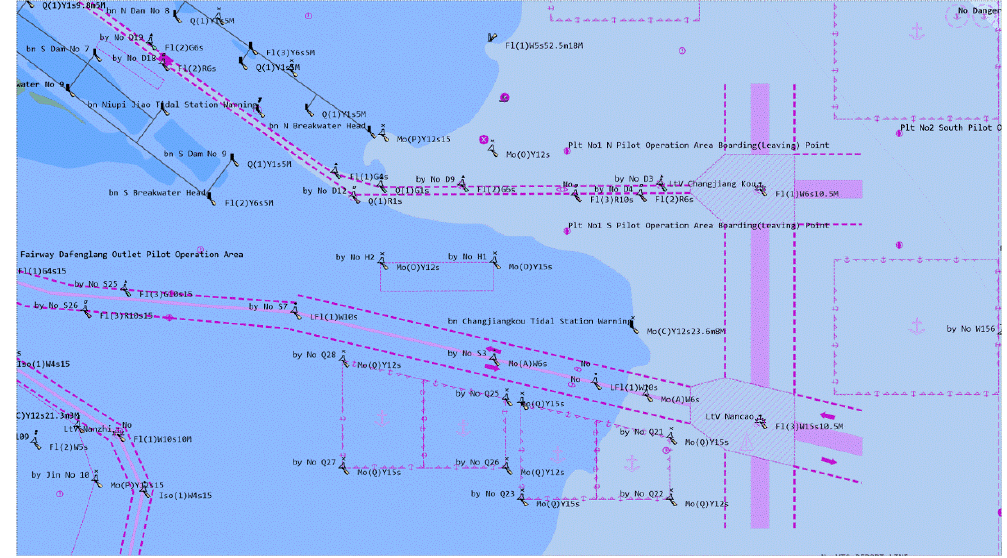
Figure 4. Chart of the Yangtze River Estuary.